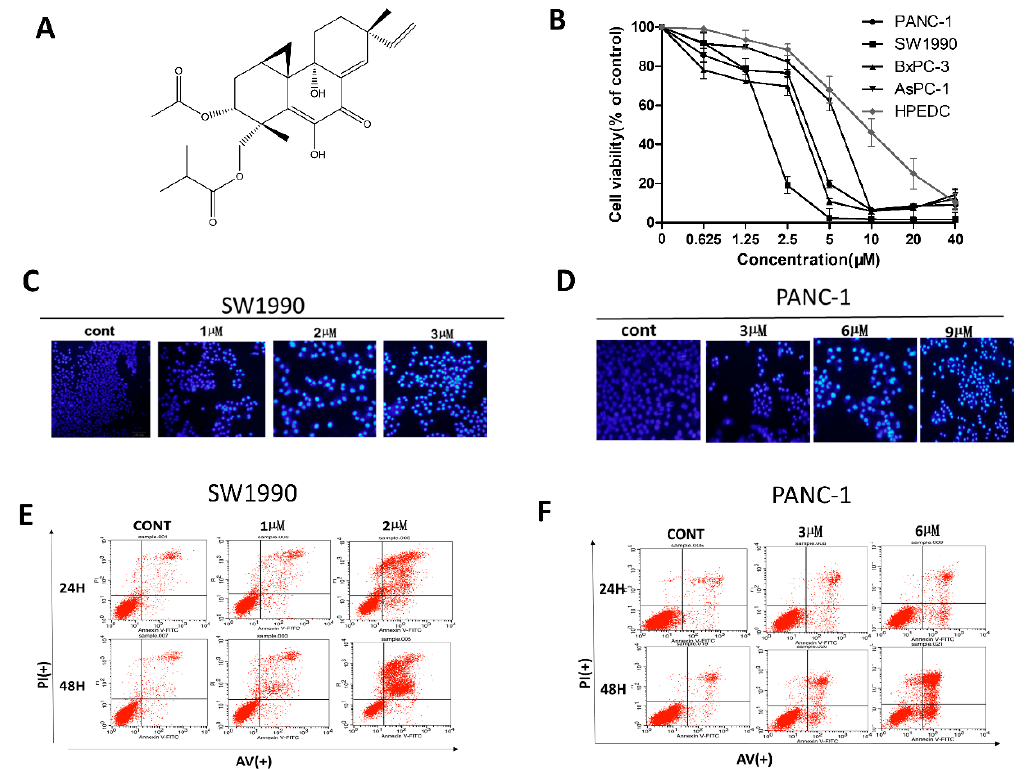
Figure 1. Effects of LH on human pancreatic cancer cell lines. ( A ), Chemical structure of LH. ( B ), Growth inhibition of LH on human pancreatic cancer cell lines PANC-1, SW1990, AsPC-1, BxPC-3 and human pancreatic duct epithelial cells HPDE6-C7. Cells were incubation with 0, 0.625, 1.25, 2.5, 5, 10, 20, 40 µ M LH for 48 h and cell viability was detected by the CCK8 assay. ( C , D ), PANC-1 and SW1990 cells were exposed to indicated concentrations of LH for 48 h, and morphological changes were indicated by Hoechst 33258 staining analysis. ( E ), SW1990 cells were exposed to 0, 1, 2 µ M LH for 24 h or 48 h. Apoptosis was analyzed by flow cytometry after Annexin V-FITC/PI staining. ( F ), PANC-1 cells were treated with 0, 3, 6 µ M LH for 24 h or 48 h. Apoptosis was analyzed by flow cytometry after Annexin V-FITC/PI